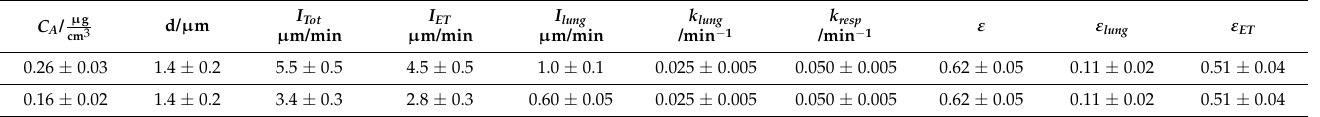
Table 1. Parameters determined from pharmacokinetic measurements for aerosol administration.